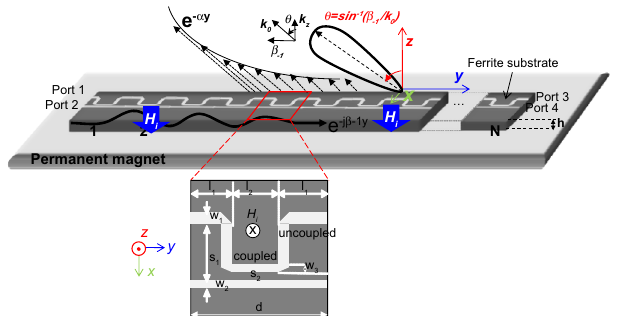
Figure 2. Coupled lines printed on a ferrite substrate having the material properties 4 p M s = 1000 G, loss linewidth D H = 10 Oe, relative permittivity e r = 14 and dielectric loss tangent tan d e = 0.0002. The internal DC magnetic field, H i is assumed to be in z direction, normal to ground plane. Unit-cell dimensions are: l 1 = 120, l 2 = 200, w 1 = 60, w 2 = 20, w 3 = 30, s 1 = 105, s 2 = 10 (mils).